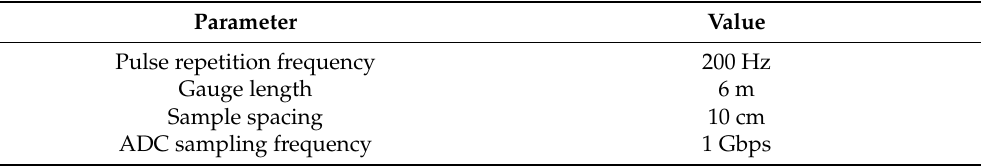
Table 1. DAS Recording